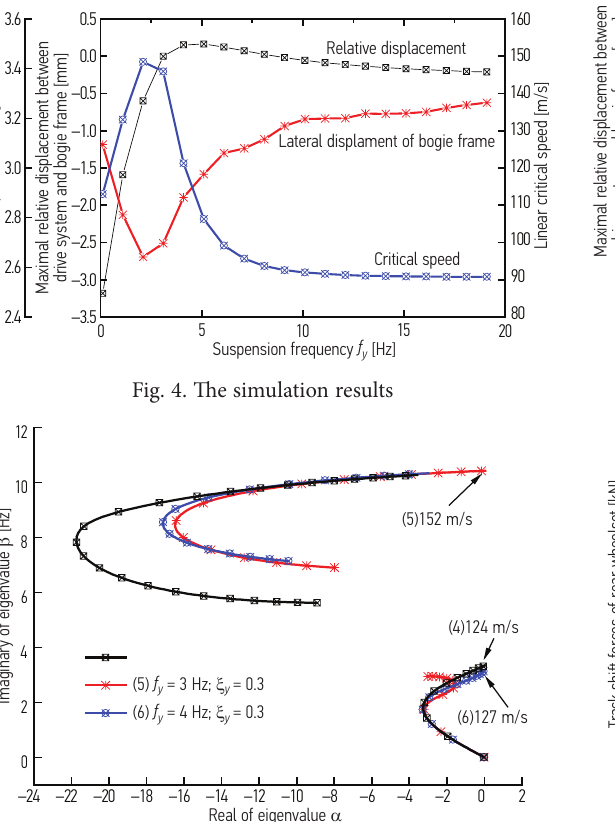
Fig. 7. The effect of ξ y on the track shift